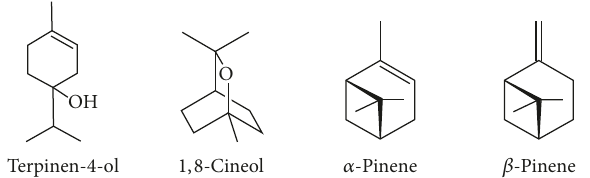
Figure 3: Main substances present in the essential oils from leaves of A. zerumbet (terpinen-4-ol; 1,8-cineol) and A. vittata ( 𝛼 -pinene; 𝛽